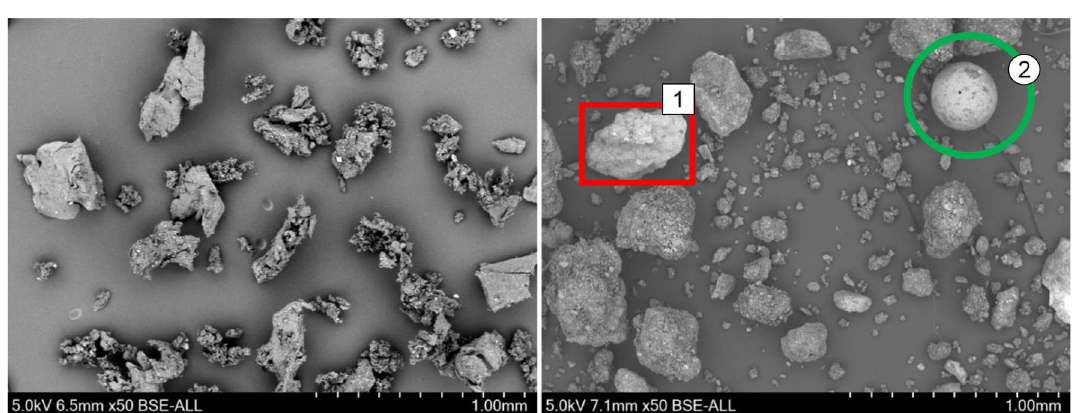
Figure 6. SEM image (50x) of rubber powder (left) and TWAP